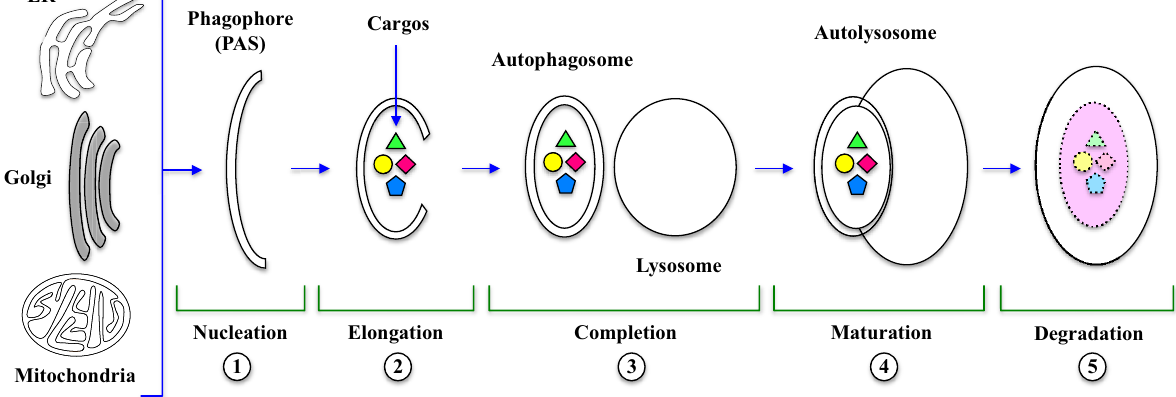
Figure 1. Autophagosome and autolysosome formation . Several morphological changes occur during autophagy, which is stepwise regulated. In the Nucleation (1) and Elongation (2) steps, phagophore originates from membranes of organelles (ER, Golgi, mitochondria) and then encloses the cytosolic cargos, including long-lived, misfolded proteins and damaged organelles, leading to the formation of the autophagosome Completion (3). The Maturation (4) step consists in the fusion of autophagosome with lysosome to form the autolysosome. Finally, during degradation (5), lysosomal hydrolases digest autolysosomal content and release products in the cytosol. PAS: Phagophore Assembly Site; ER: endoplasmic